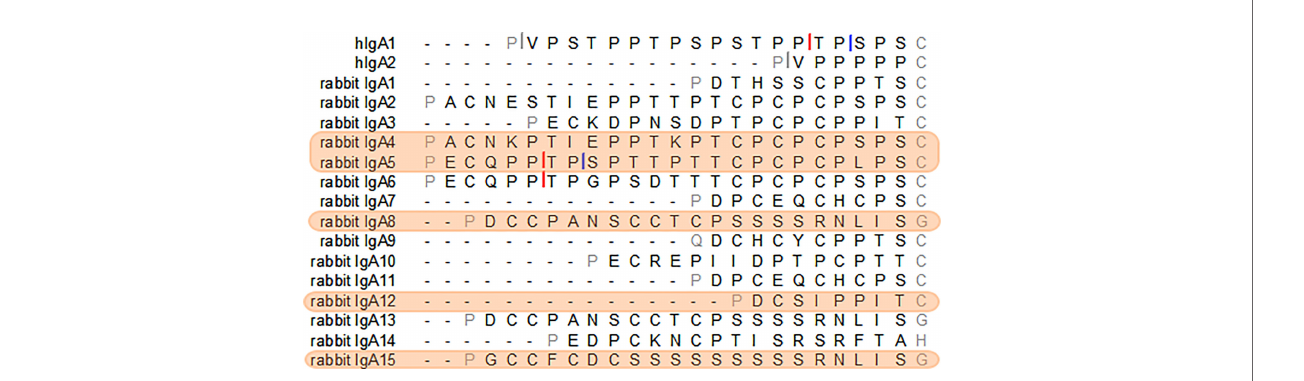
FIGURE 1 | The amino acid sequence of the hinge regions of the human IgA1 and IgA2m (1) and the 15 European rabbit IgAs. Cleavage sites of Clostridium ramosum and Neisseria meningitidis cleavage type 1 and type 2 proteases in human IgAs are indicated with grey, blue and red bars, respectively. Putative sites of cleavage in the rabbit IgAs are indicated. The selected rabbit IgA hinges for this study are highlighted in